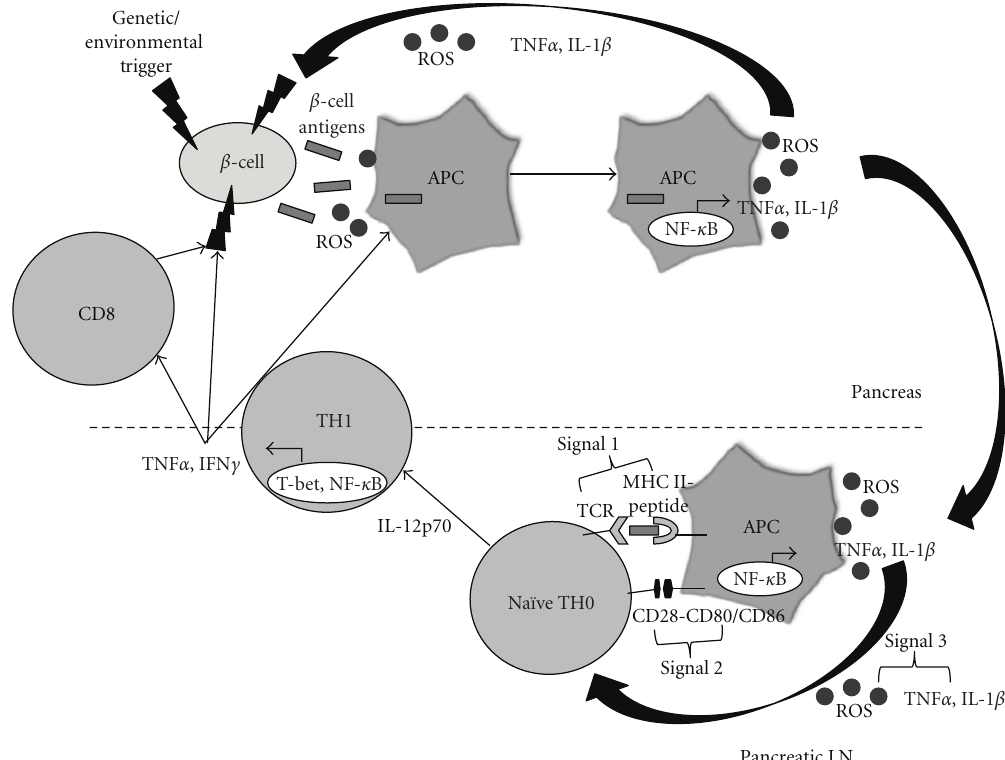
Figure 1: Role of redox in the immunopathology of type 1 diabetes . An initial genetic or environmental insult to the beta cell triggers the release of beta cell antigens as well as the production of ROS. Beta cell antigens are phagocytosed, and ROS are able to stimulate redox-dependent transcription factors such as NF- κ B, which leads to APC activation and cytokine secretion. ROS and proinflammatory cytokines secreted by APCs act as the third signal within the T-cell-APC immunological synapse, which occurs in the pancreatic lymph node. ROS play a critical role in the progression of na¨ıve TH0 cells to cytokine-secreting TH1 cells. Release of IFN γ by TH1 cells then works directly on the beta cells as well as activates more APCs and CD8 cells, all of which can impart deleterious e ff ects on the